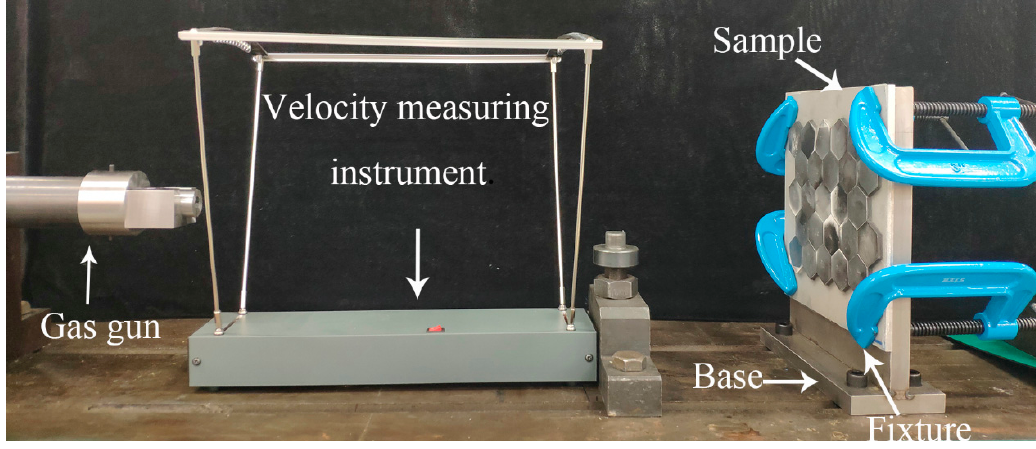
Figure 3. Impact test devices.